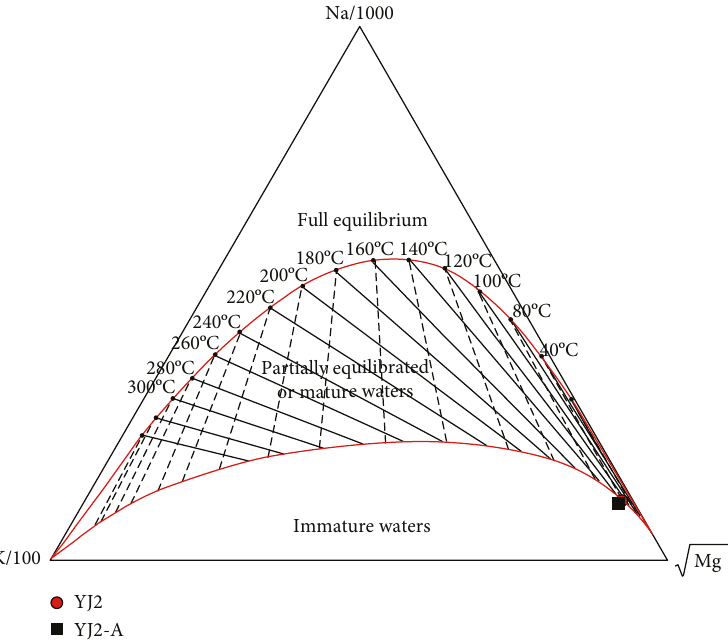
Figure 4: Triangular diagram of Na-K-Mg 1/2 . YJ2: water sample of the hot spring taken in 2014; YJ2-A: water sample of the hot spring from Local Chronicles Compilation Committee of Yunnan Province